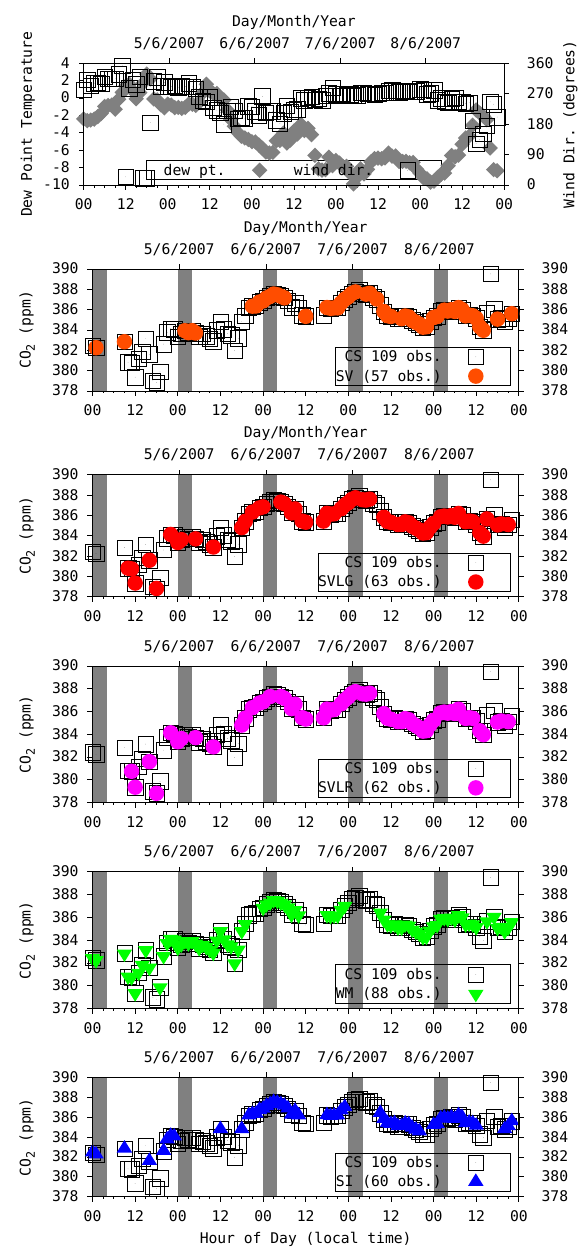
Fig. 7. Synoptic case (4–8 June 2007) same as Fig. 6 but with tran- sient wind direction shift near 12:00LT on 4 June. The gray bands locate 00:00–04:00LT measurements, which are the hours assimi- lated by some inversion model